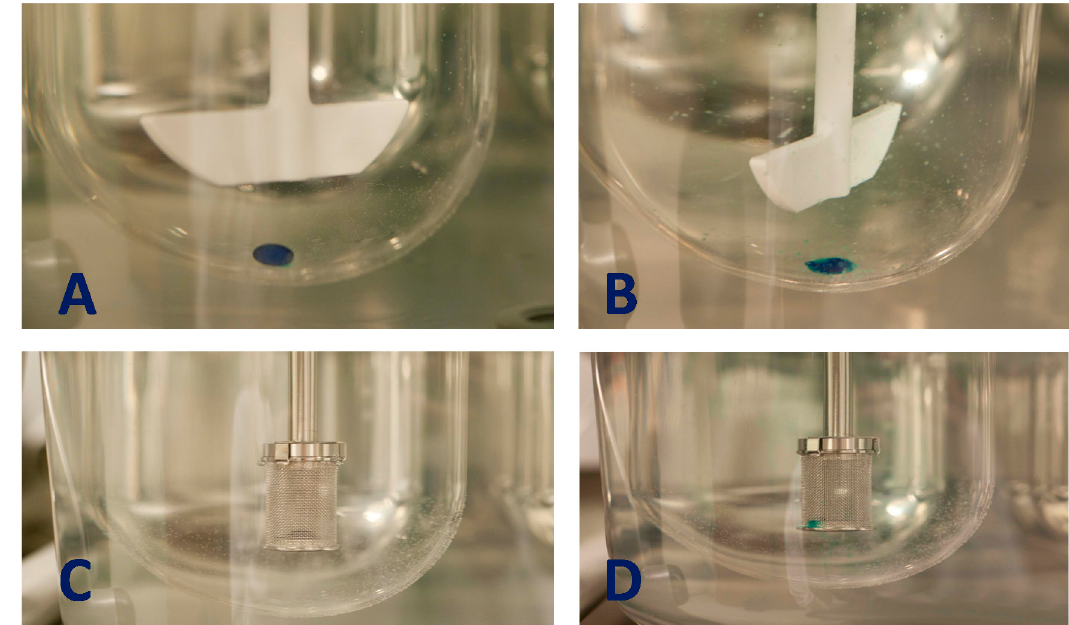
Figure 8. Dissolution of loratadine SGCs using apparatus 1 and 2. ( A , B ) represent time 0 and 5 min, respectively (apparatus 2). Oil droplets from the soft gel capsules can be seen in the dissolution media in ( B ). The visual observation of dissolution of the same drug product using USP apparatus 1 is presented by panels ( C , D ) at time 0 and 5 min, respectively. No pellicle formation or clogging of the basket mesh could be observed.